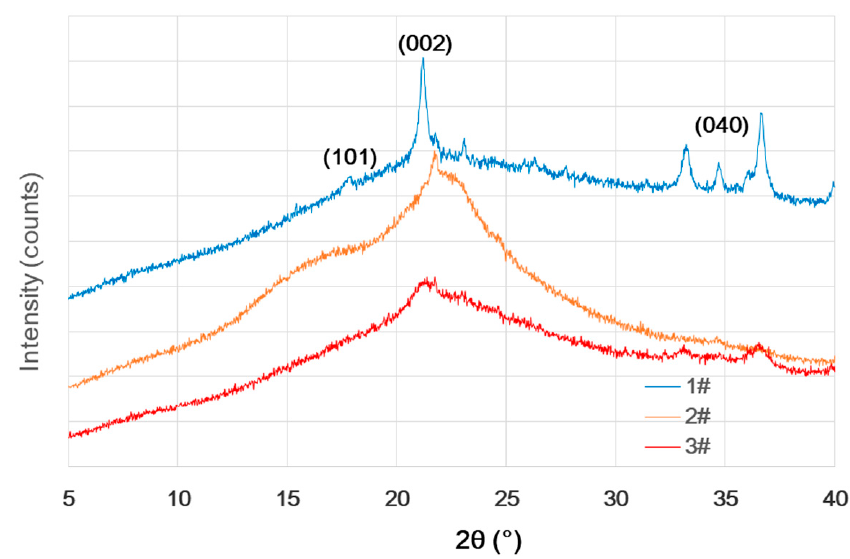
Figure 1. X-ray diffraction pattern of ancient shipwreck wood from Huaguang Jiao No. 1.